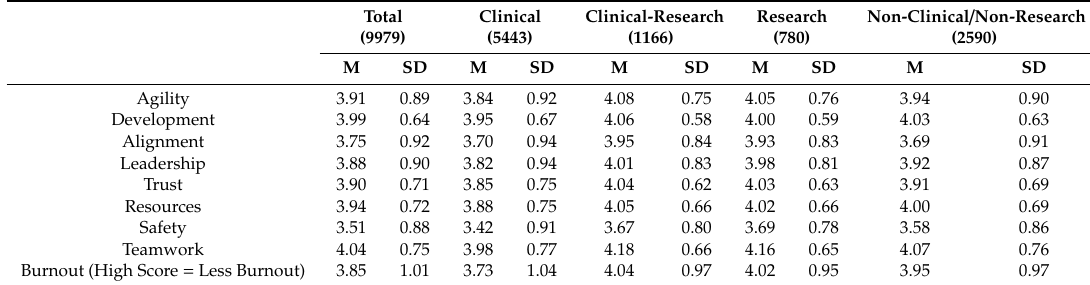
Table 3. Mean (SD) of employee attitude predictors and burnout by department